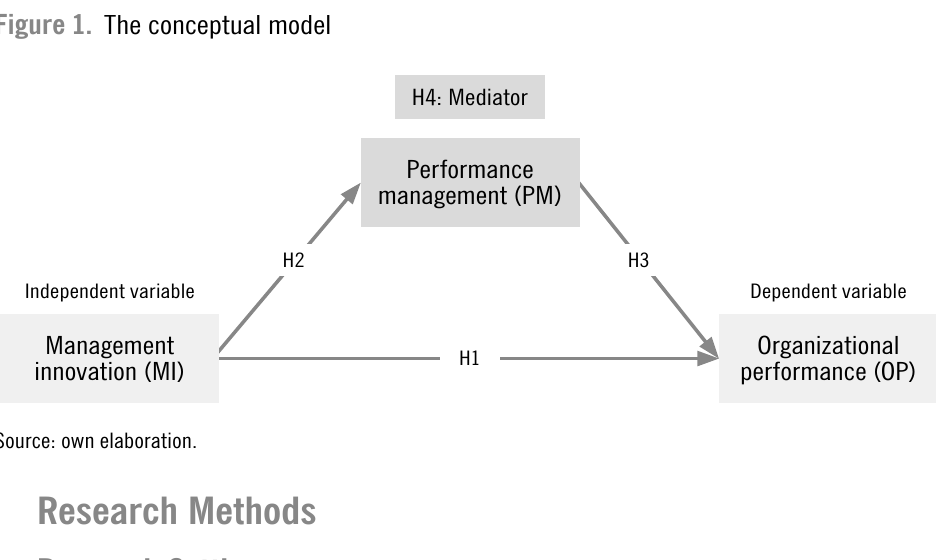
Figure 1. The conceptual